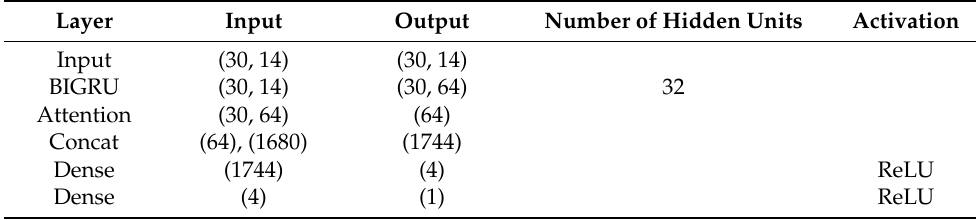
Table 7. The parameters of the remaining useful life prediction model.